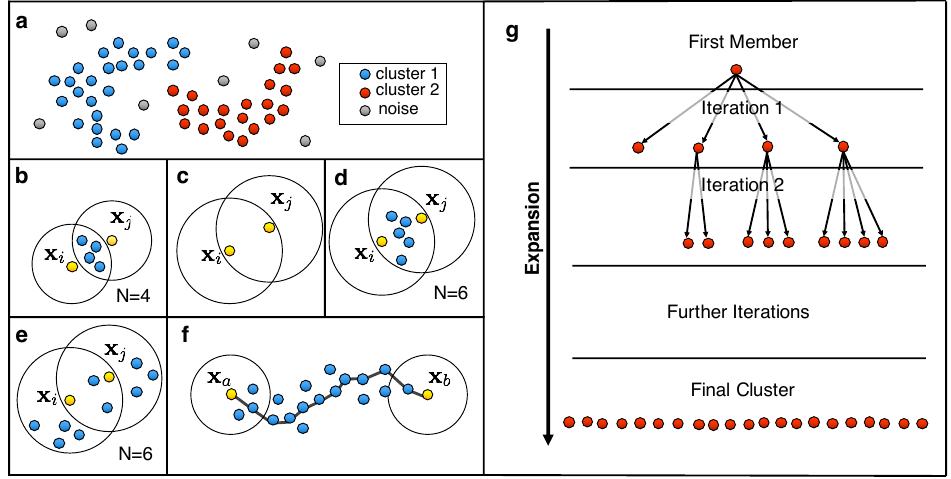
Figure 4. Clustering process using the common nearest neighbor (CNN) algorithm: ( a ) A dataset that consists of two clusters and several noise points. ( b – e ) Depiction of the density criteria that determine whether two data points x i and x j belong to the same cluster: ( b ) The first density criterion, N shared nearest neighbors, is fulfilled. ( c ) The second density criterion, x i and x j are nearest neighbors with respect to the other data point, is fulfilled. ( d ) Both criteria ( b , c ) are fulfilled at the same time. Hence, x i and x j belong to the same cluster. ( e ) One criterion is fulfilled, the other is not. Hence, x i and x j do not belong to the same cluster. ( f ) x a and x b fulfil no density criteria but belong to the same cluster as they are density-connected (reproduced from Lemke, O.; Keller, B.G. “Density-based cluster algorithms for the identification of core sets”, J. Chem. Phys. 2016 , 145 , 164104, with the permission of AIP Publishing). ( g ) Depiction of a clustering process over several cluster expansion steps (iterations). We note that the cluster is expanded by adding single data points to the current cluster that fulfil the density criterion with respect to a data point within the